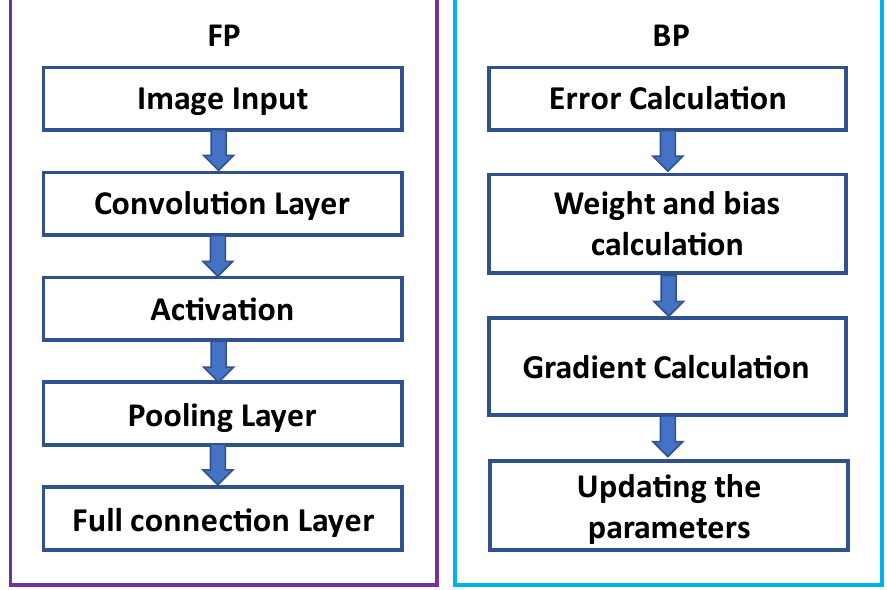
Figure 16. Schematic of FP and BP